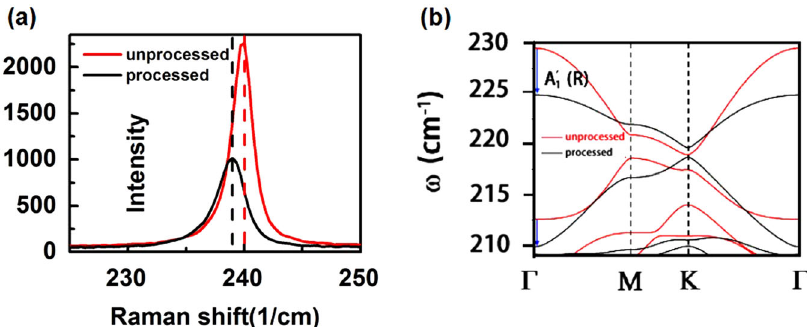
Fig. 4 The vacancy repair con fi rmed by Raman spectroscopy. a Raman spectra of the unprocessed ( red ) and processed ( black ) SLM sheets. b The calculated phonon dispersion curves of the unprocessed ( red ) and processed ( black ) SLM sheets,